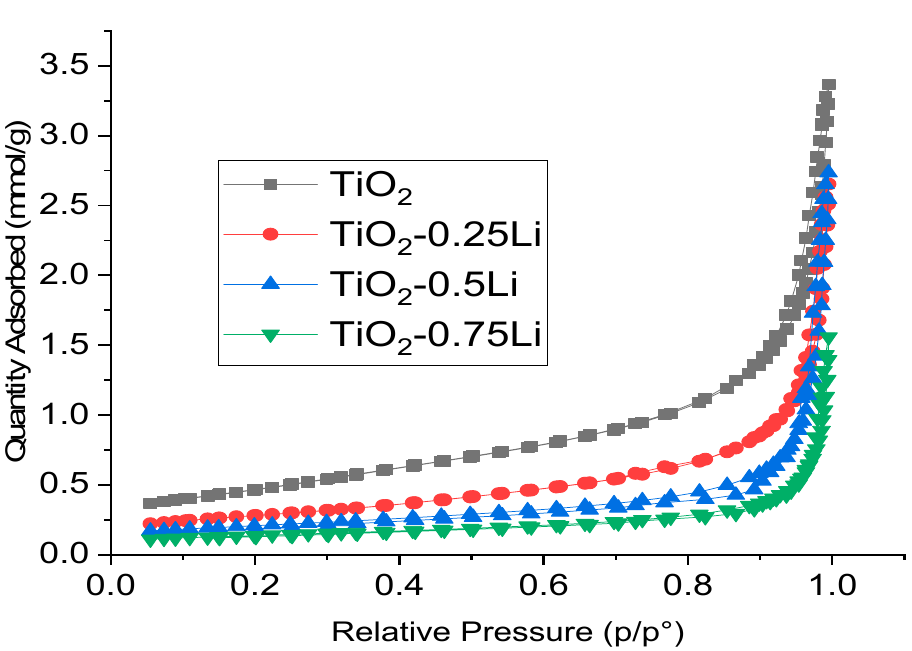
Figure 4. BET isotherm plots of the synthesized catalysts.